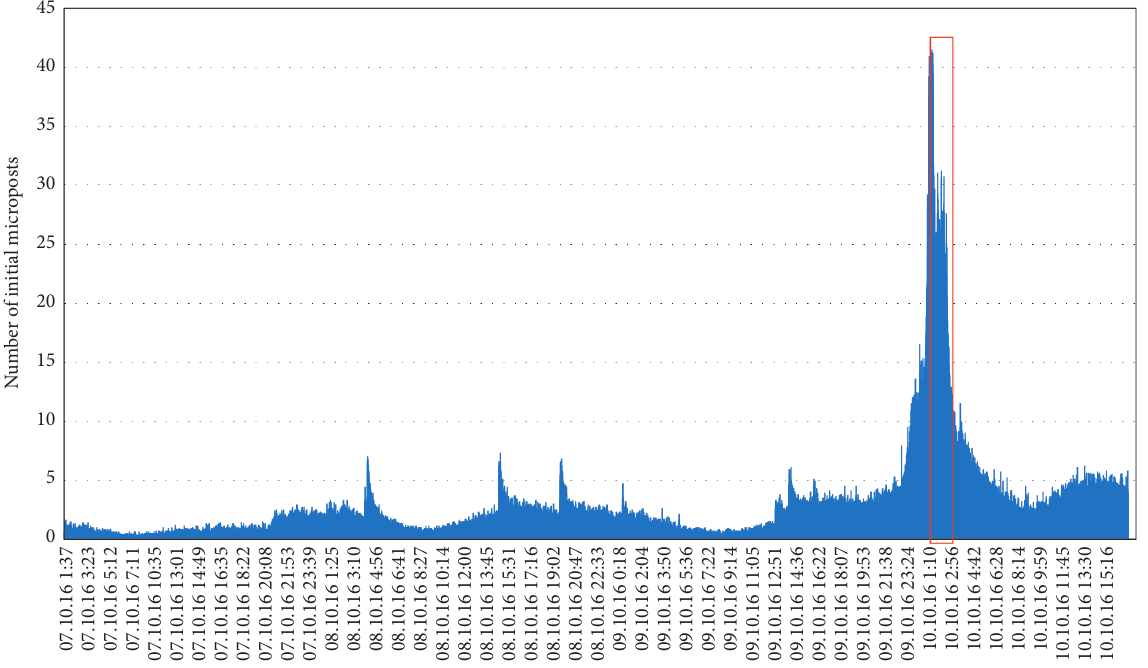
Figure 4: The dynamics of initial microposts corresponding to the second